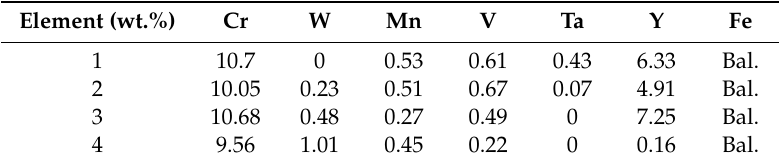
Table 2. Chemical composition of the points indicated in Figure 6c.